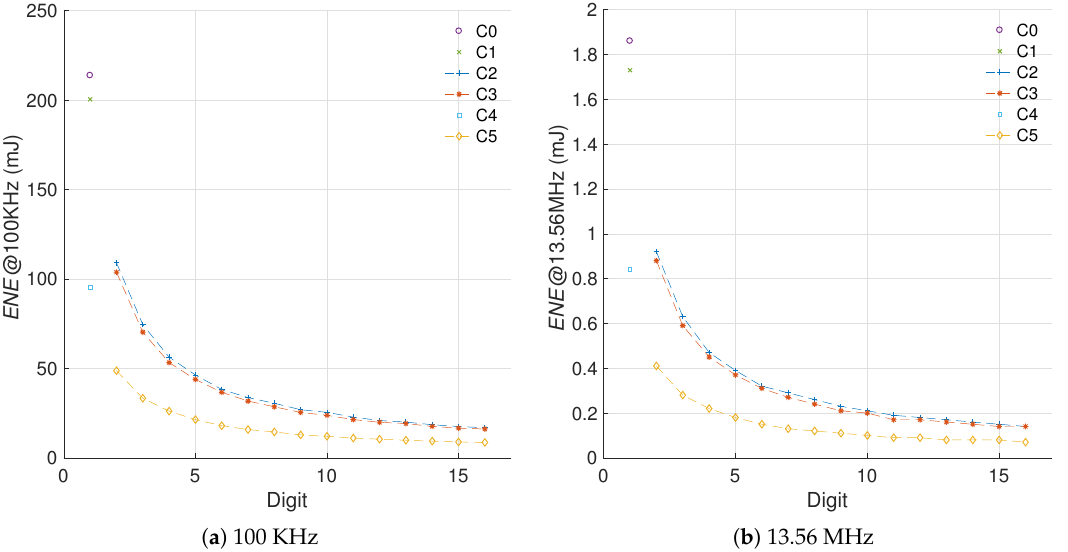
Figure 9. Energy consumption of the kP architectures at different operational